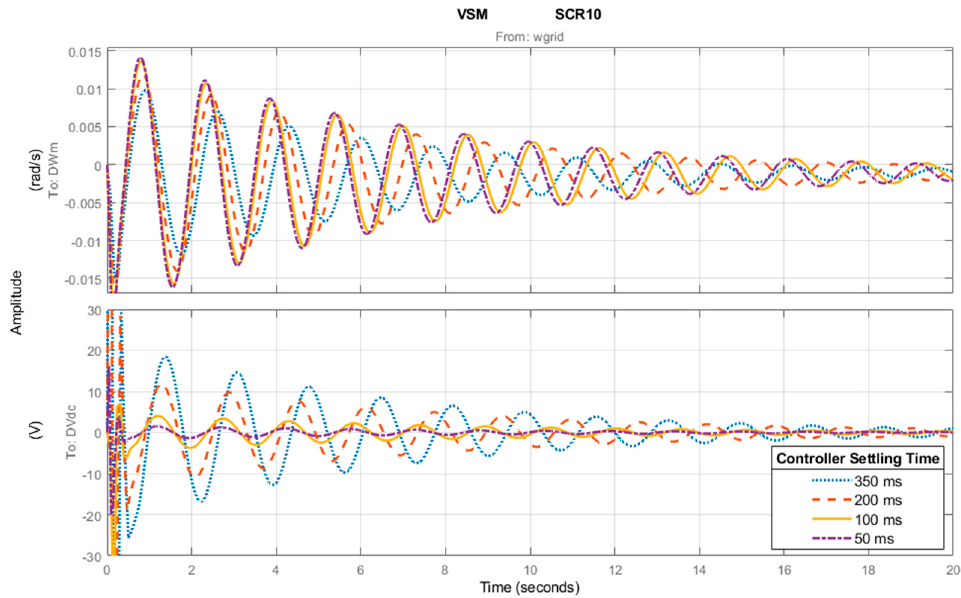
Figure 17. Step response comparing the generator ‐ side DC link voltage controller tunings.